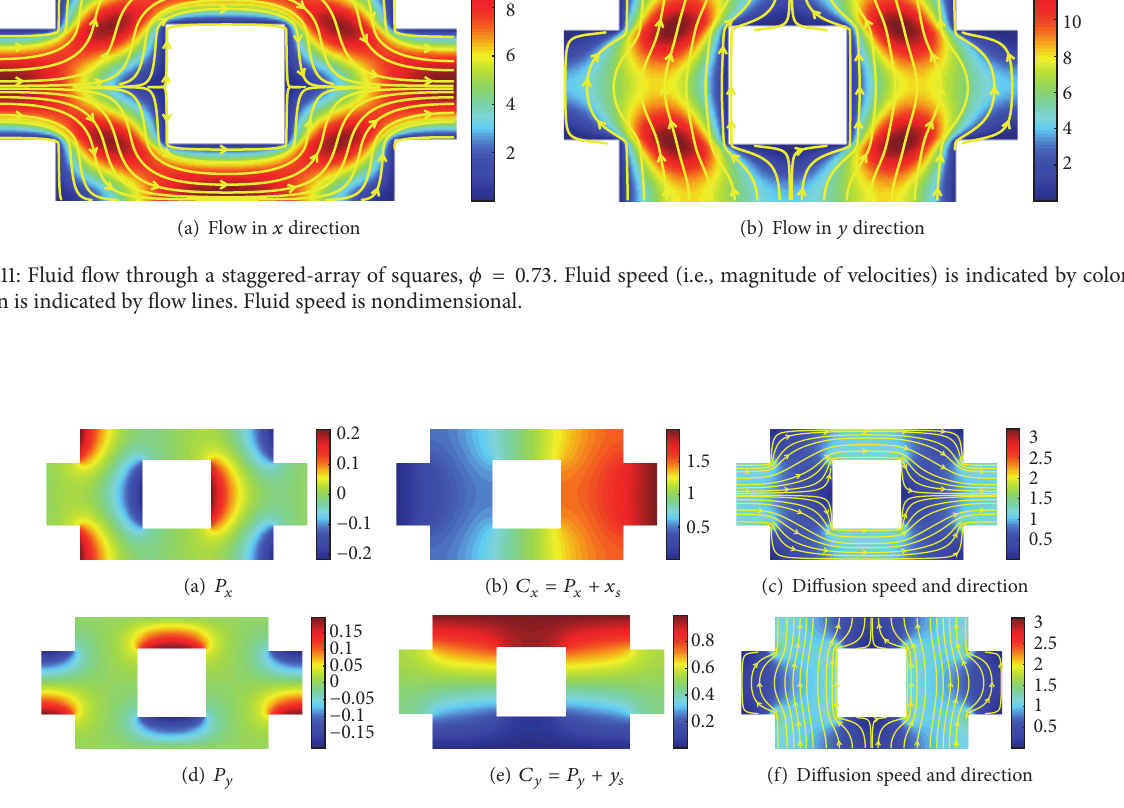
Figure 12: Fields for a staggered-array unit cell of 𝜙 = 0.73 : (a, d) solution to the homogenization problem, (b, e) concentration field transformed from 𝑃 𝑘 (assuming concentration gradient across unit cell is one), and (c, f) magnitude of concentration gradient (diffusion speed) and